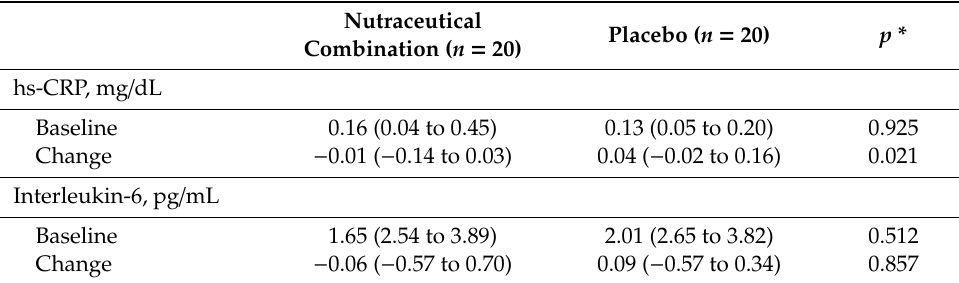
Table 4. Baseline levels and changes in anti-inflammatory parameter variables in the nutraceutical and placebo groups.